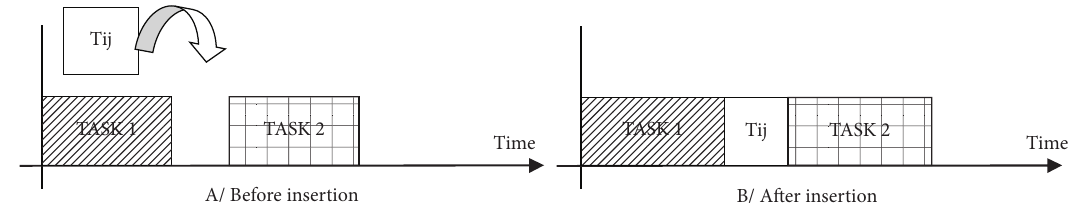
Figure 3: Principle of static insertion. (a) Before insertion. (b) After insertion.